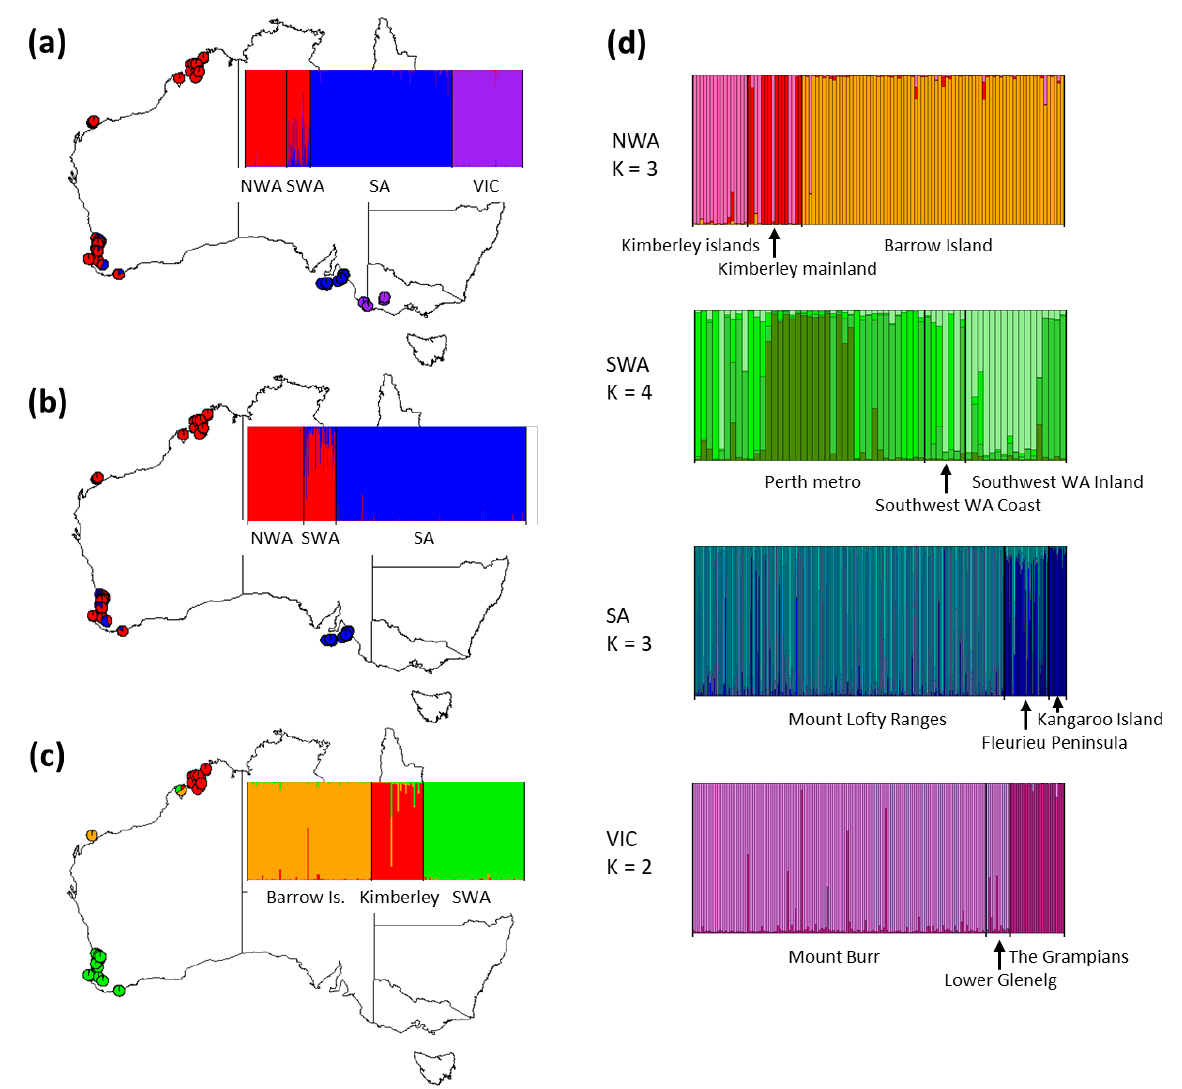
Figure 4. Summary of the hierarchical clustering analysis using STRUCTURE based on 10 microsatellite loci. The analyses include ( a ) all samples, ( b ) excluding Victoria, ( c ) excluding Victoria and South Australia, and ( d ) regional populations. Pie charts on Australia maps illustrate individuals’ estimated membership to each genetic cluster relative to their geographic locations. Barplots in ( d ) show the most likely K value for each region. Regions include northern Western Australia (NWA), southern Western Australia (SWA), South Australia (SA), and Victoria (VIC). Black lines in barplots separate samples from different sampling locations. Each coloured bar represents an individual with different colours reflecting estimated proportional membership to particular